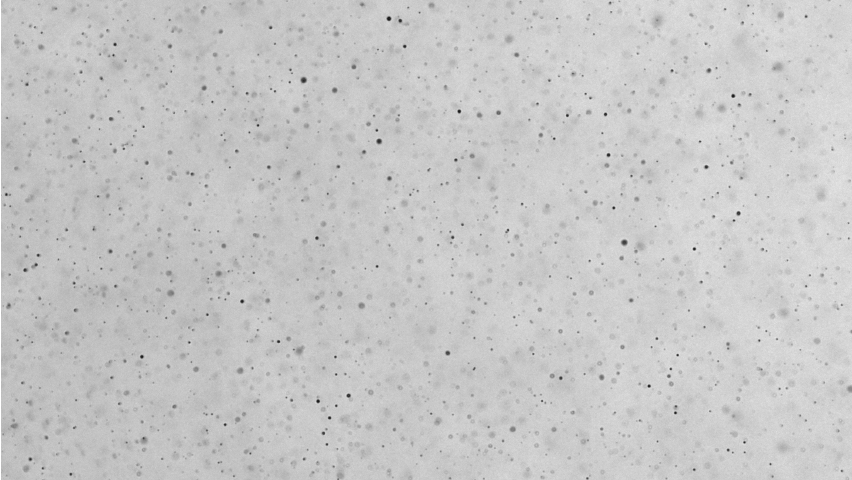
Figure 3. A typical shadow image of droplets produced by an ultrasonic droplet generator. The image was taken during laboratory tests with a camera lens magnification setting of ×